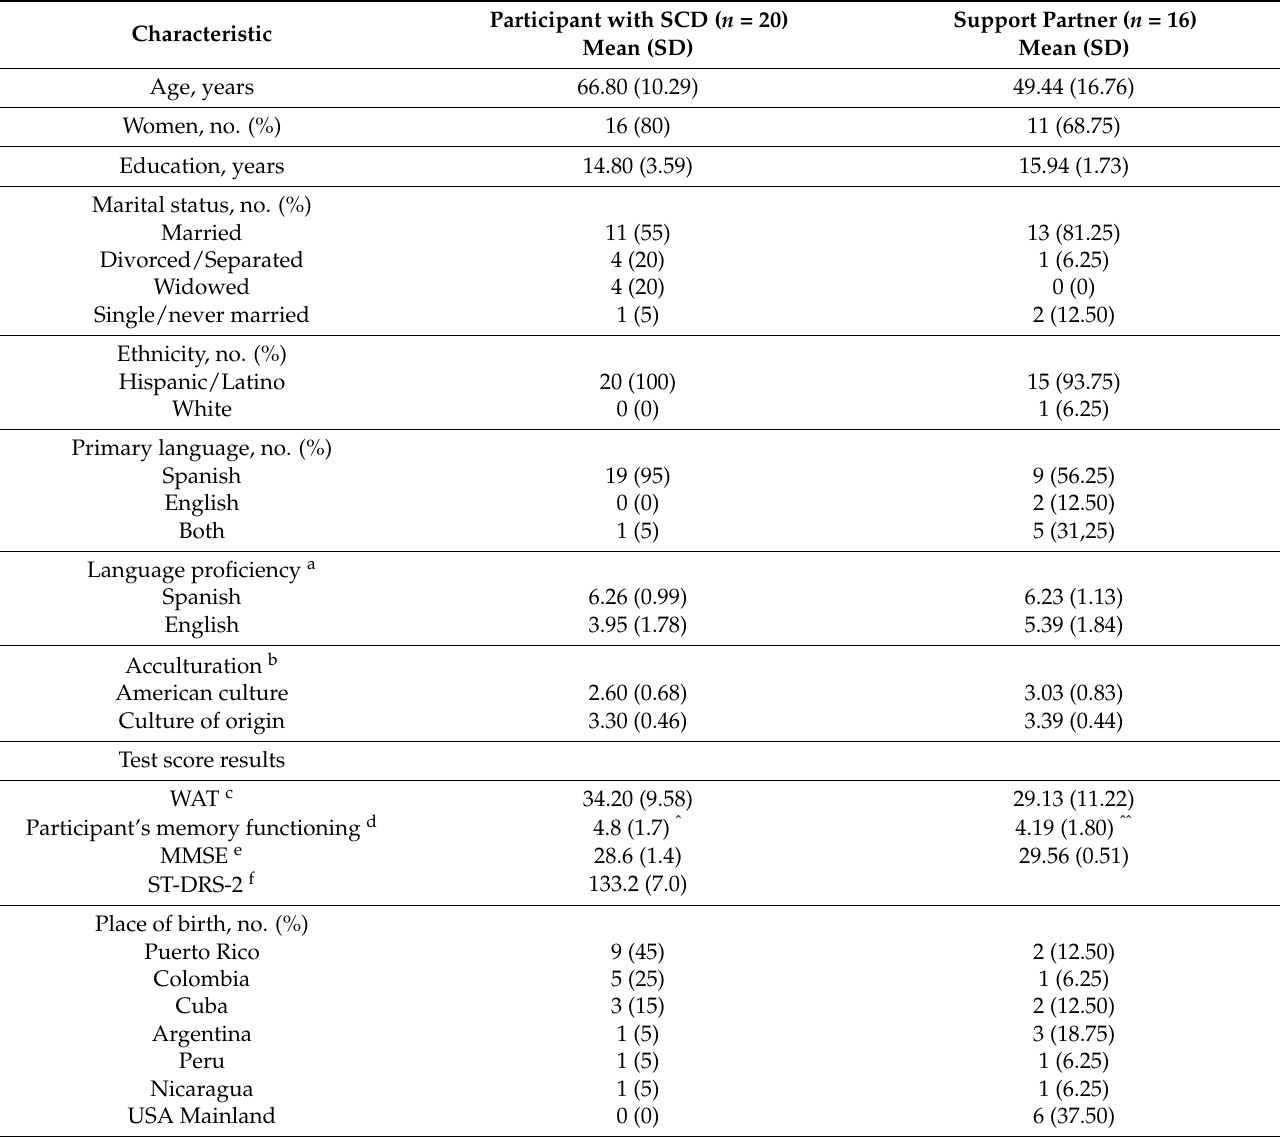
Table 1. Participant characteristics and baseline test